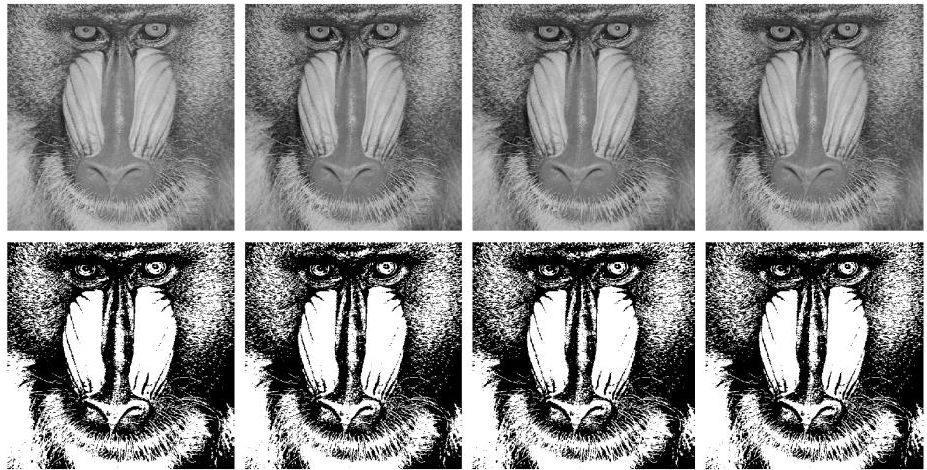
Figure 12. Visual analysis (forensics) of the baboon stego